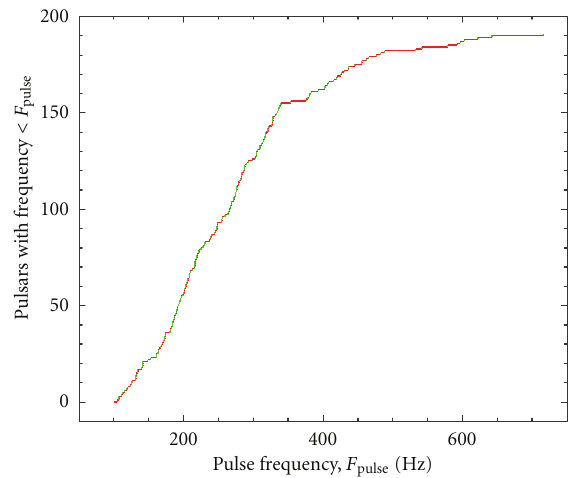
Figure 9: The distribution of pulsars from the ATNF pulsar database with spin rates greater than 100 Hz (http://www.atnf .csiro.au;